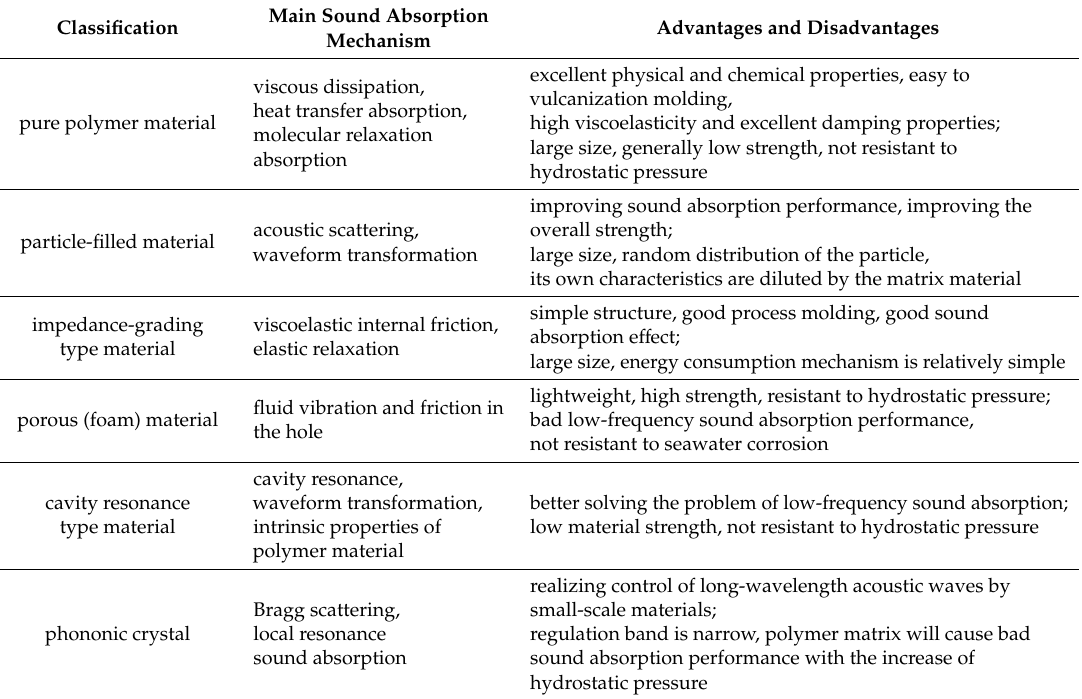
Table 2. Classification of underwater sound absorption materials, main sound absorption mechanism, advantages and disadvantages